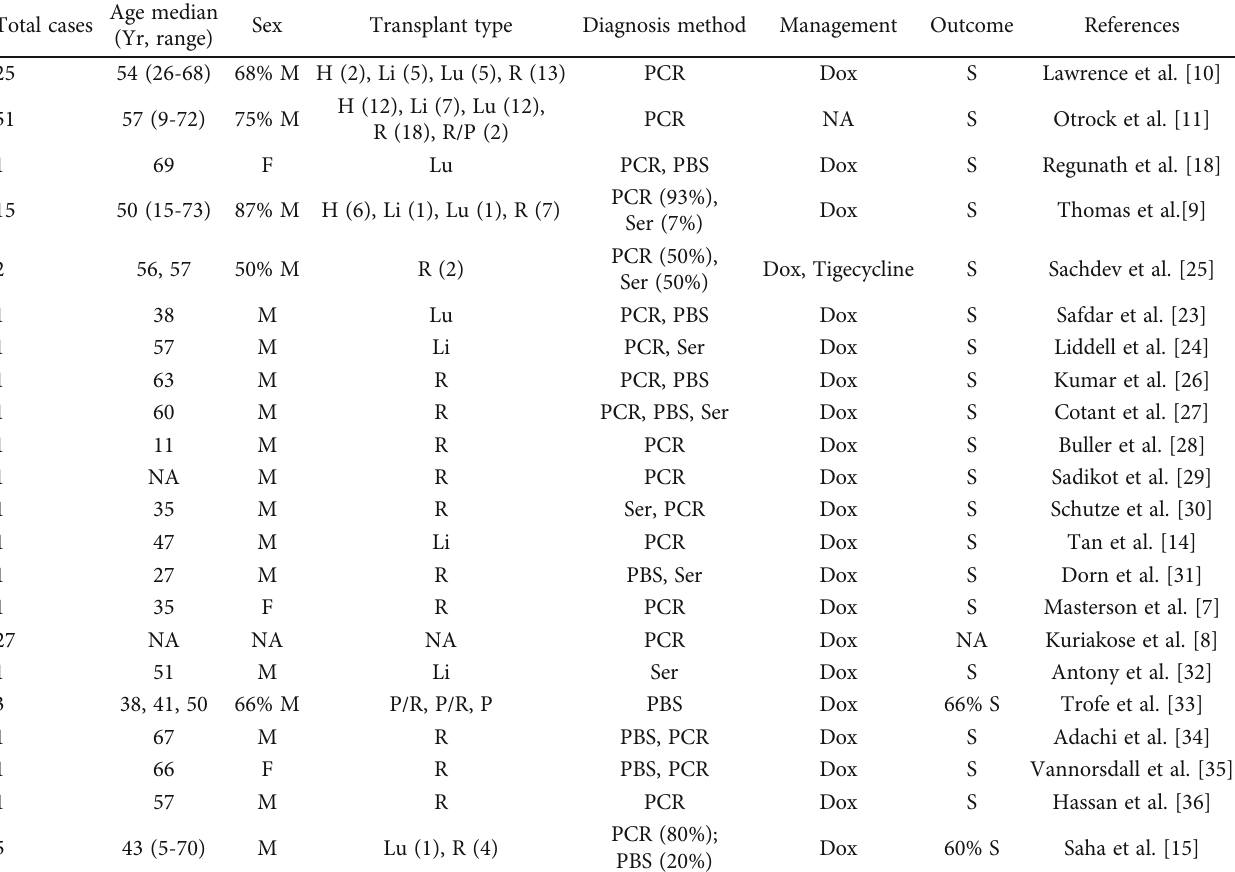
Table 1: All cases of ehrlichiosis complicating solid organ